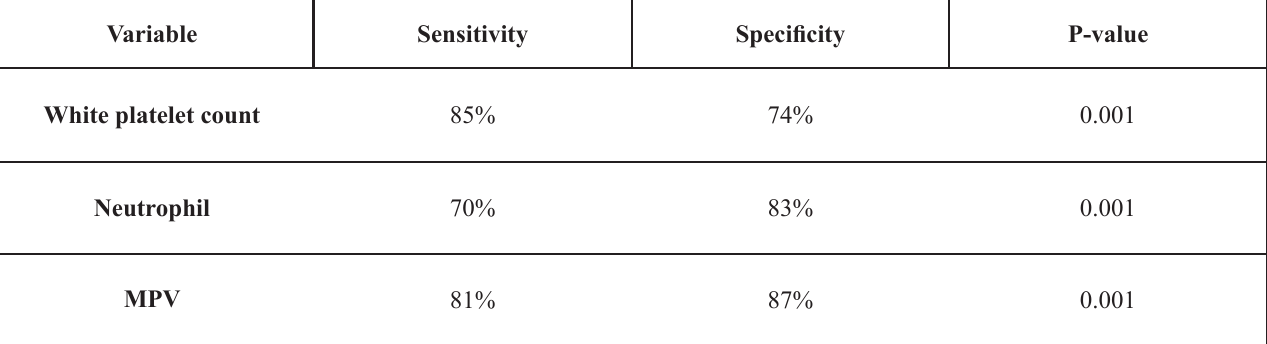
Table 2. Comparison of sensitivity and specificity in the studied variables